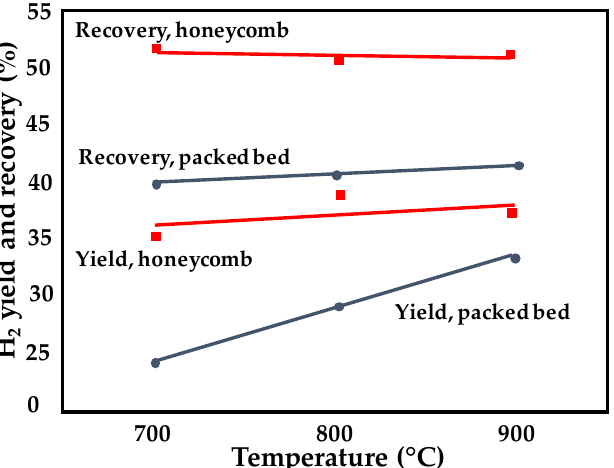
Figure 5. Change in the efficiency of a Ni–Cu membrane as a function of reaction temperature and catalytic system employed (powder vs. structured sample). Reprinted from [51]; P = 10 atm; H 2 O/C 2 H 5 OH = 4; flow rates of 5 Nl h − 1 for the feed gas and 10 Nl h − 1 for the sweep gas.